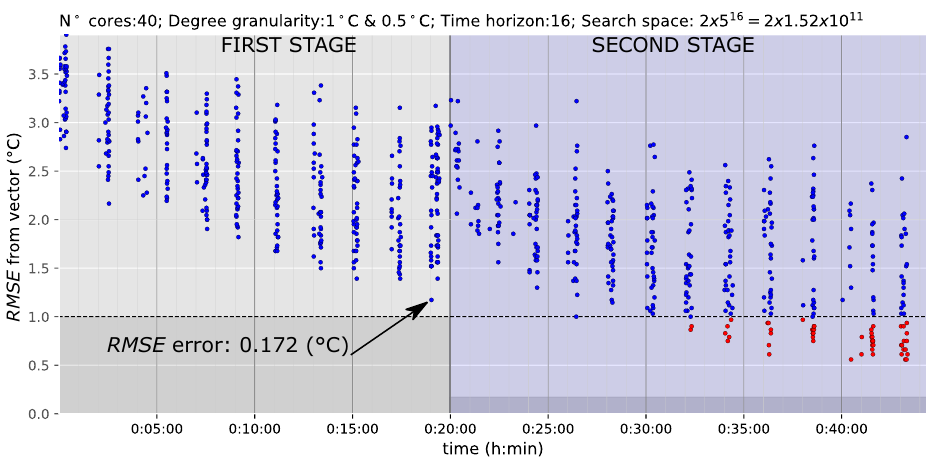
Figure 10. MPC results using two stages to obtain the MPC vector (16